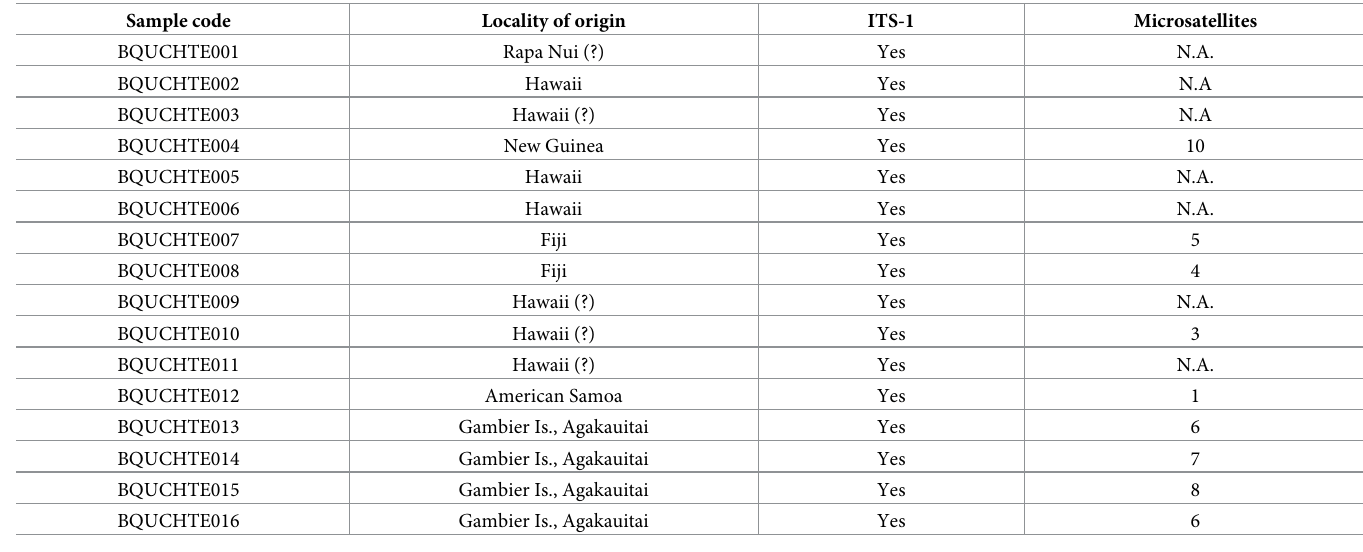
Table 2. Summary of amplification of DNA from barkcloth textile samples with different molecular markers. Sample